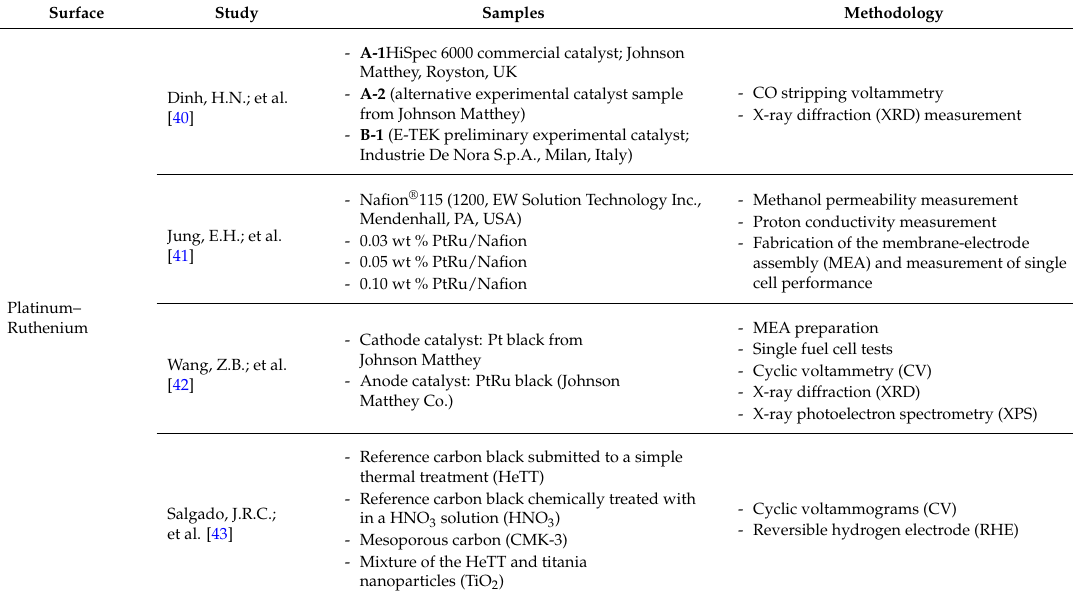
Table 1. Experimental Details of the selected studies per catalyst, on chronological